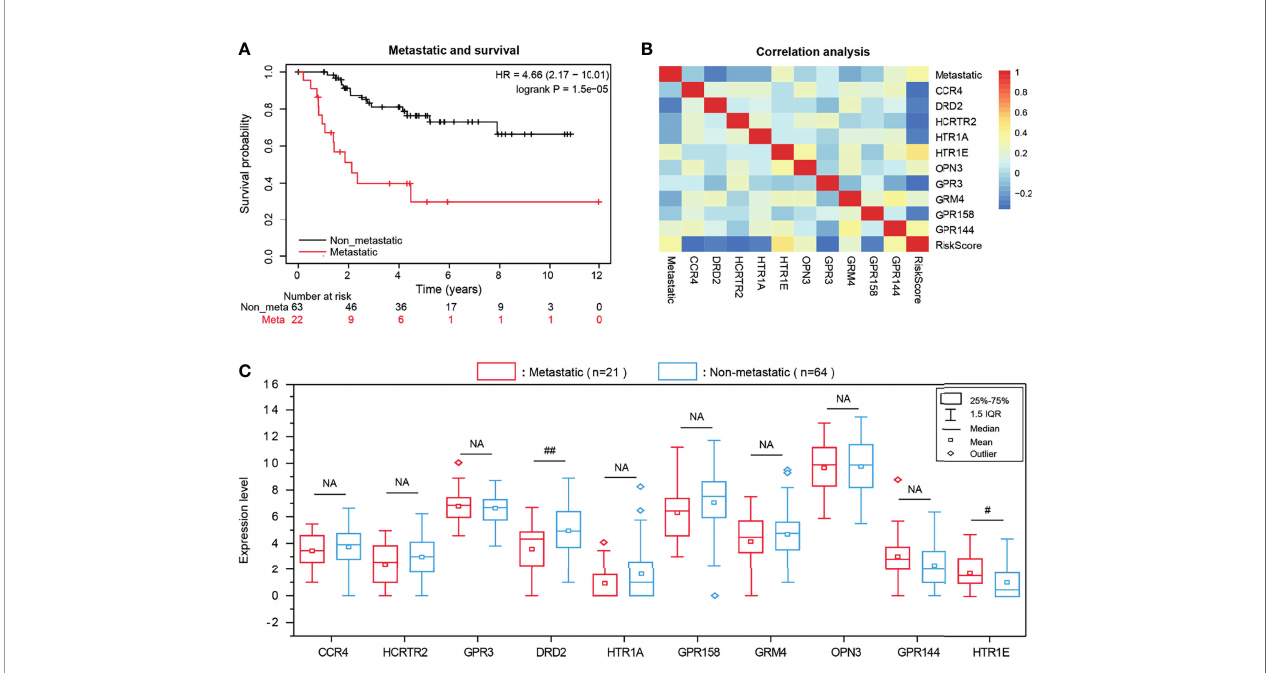
FIGURE 6 | (A) KM survival curve of OS metastasis and patient survival rate. (B) The Pearson correlation among the expression of 10 GPCRs and OS metastatic and risk scores. (C) The expression level of risk genes in OS metastatic and non-metastatic samples, NA represents no signi fi cance, “ # “ represents 0.01 <P < 0.05, “ ## ” represents 0.001 <P <